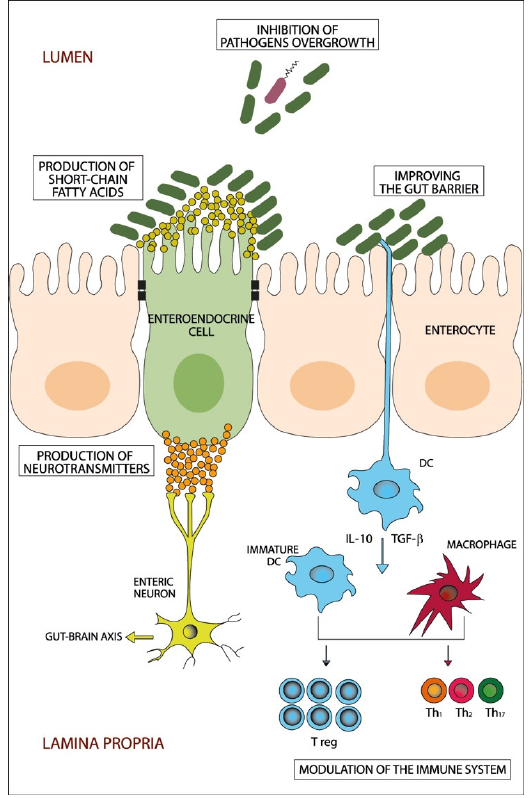
Figure 1. A schematic diagram showing the potential beneficiary effects of probiotics on the gut. Probiotics beneficially manipulate the dysbiotic gut through different potential mechanisms that include inhibition of pathogens’ overgrowth, improving the gut barrier, production of short-chain fatty acids and neurotransmitters and modulation of the immune system. DC: dendritic cells; IL: interleukin; Th: T helper cell; T reg: T regulatory cell; TGF-β: Transforming growth factor-β. On the other hand, the use of nonabsorbable antibiotics, such as rifixamin, has been investigated in several double-blinded and placebo-controlled randomized controlled tri- als [71,76] and has been approved by the US Food and Drug Administration for treating patients with diarrhea-predominant IBS [77]. It is suggested that the beneficial effect of using rifixamin in repeated courses occurs by reducing the total load of the gut microbiota